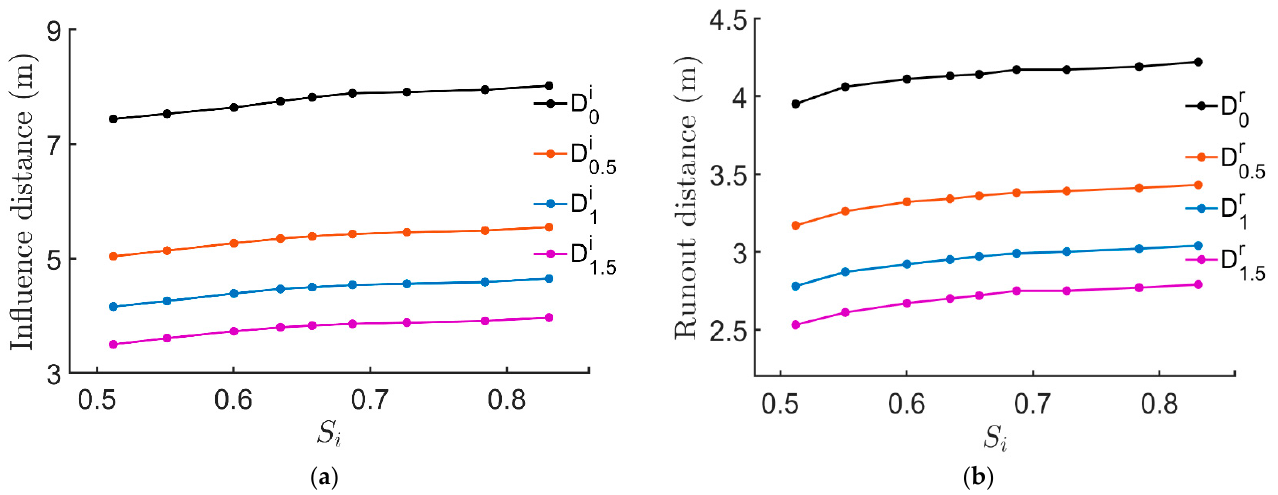
Figure 15. Variations in influence distances and runout with different hydraulic conductivity values: ( a ) different influence distances in uniform slopes; ( b ) different runout distances in uniform slopes.